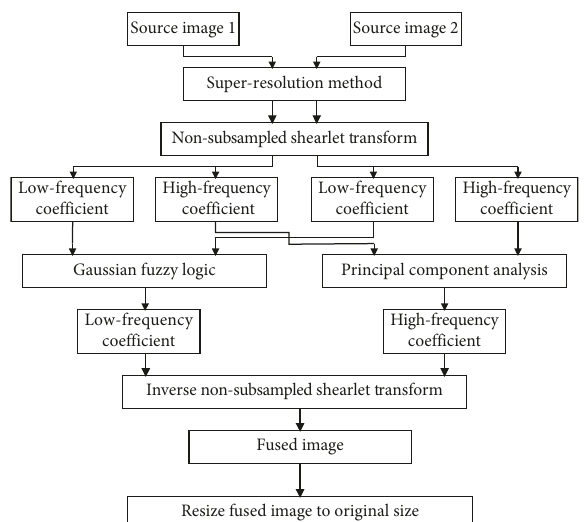
Figure 11: Flow chart of the proposed